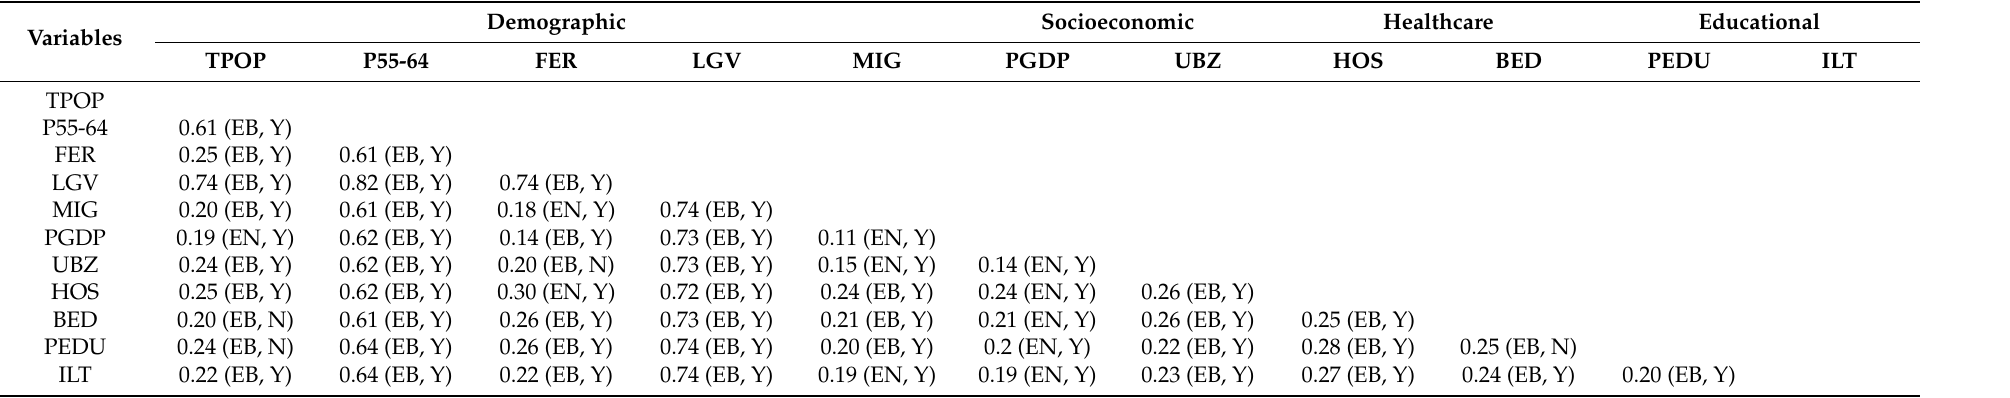
Table 5. The interaction detector analysis and statistically significant differences of the driving factors on